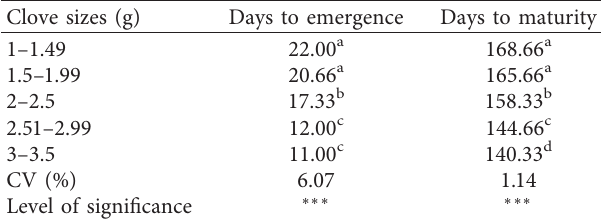
Table 1: Effect of clove sizes on days to emergence and maturity. Clove sizes